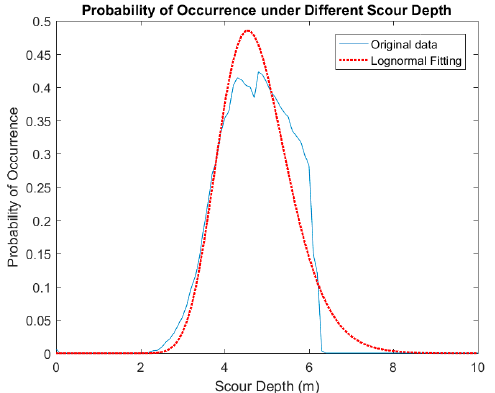
Figure 11. Scouring depth probability density function for the 100 year return period.